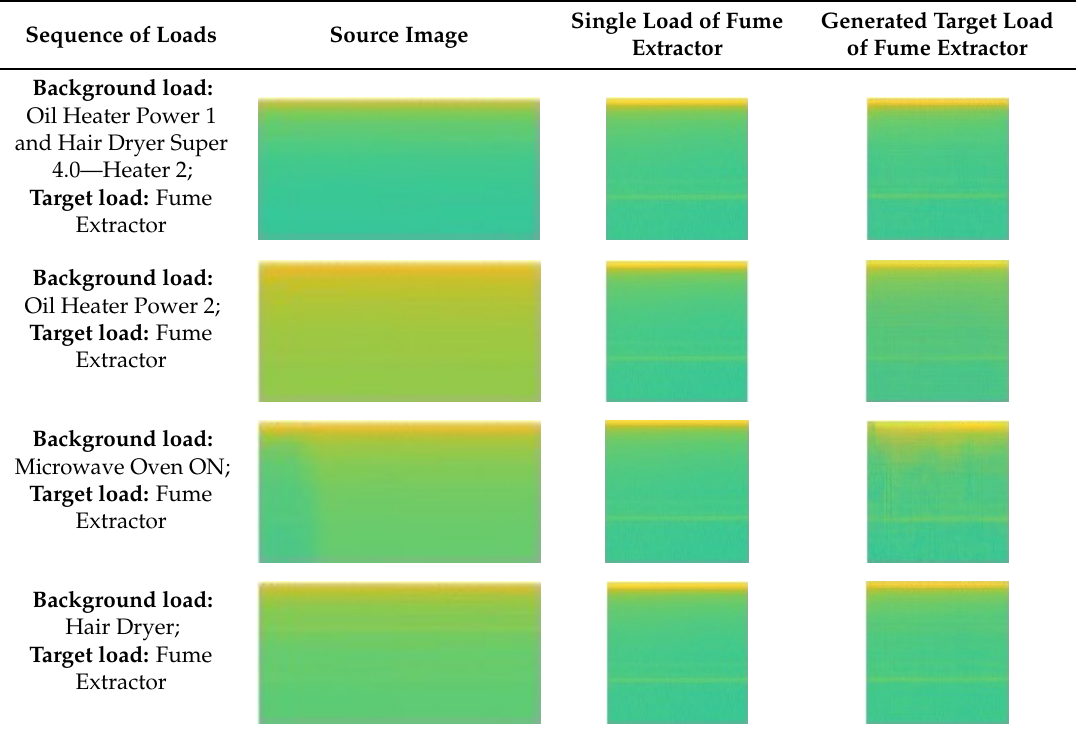
Table 6. Several results of GAN inference with Fume extractor as target